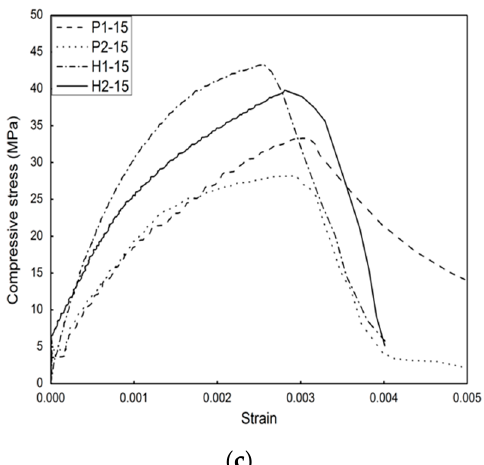
Figure 12. Stress–strain relationship. ( a ) At a volume fraction of 0.5%; ( b ) at a volume fraction of 1.0%; ( c ) at a volume fraction of 1.5%.